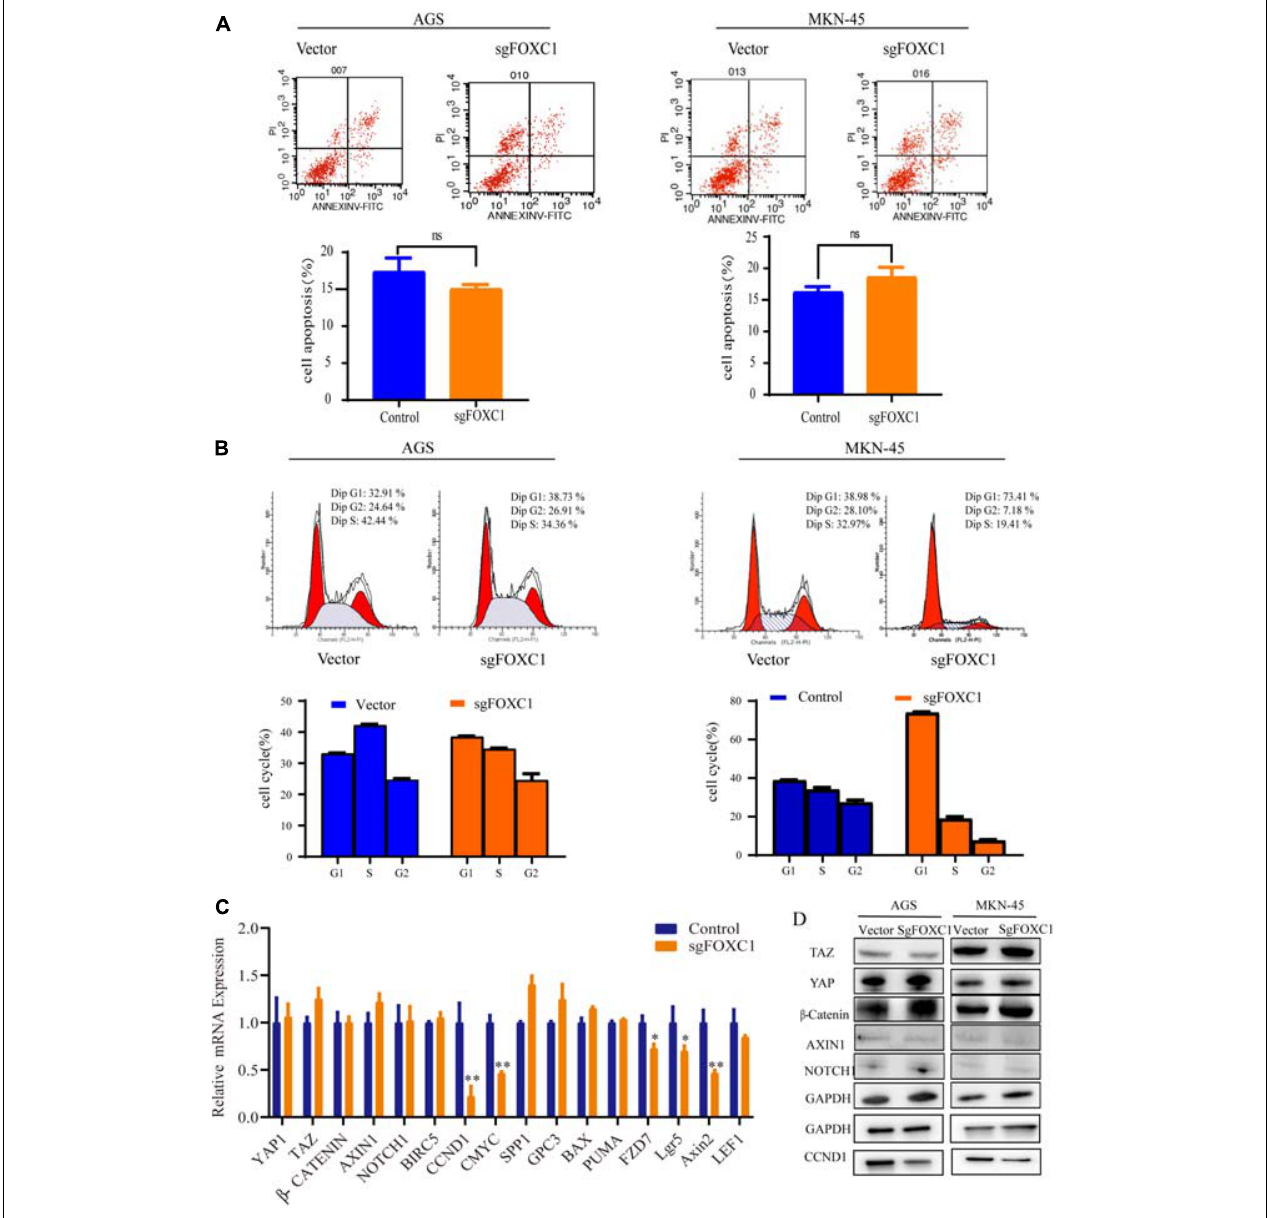
FIGURE 3 | Altered expression of FOXC1 affects the cell cycle in GC. (A) Annexin-V & Dead Cell (7-AAD) flow cytometry analysis to evaluate cell apoptosis. In the right-down panel in each plot was considered as early meaningful apoptosis. Representative figure of the three replicates of each proportion of early apoptosis was shown in panel (A) . The results flow cytometry assay on cell apoptosis in FOXC1 KO cell lines (AGS cells and MKN-45 cells) had no significant influence on cell apoptosis. Values are presented as the mean ± standard deviation of three independent experiments ( P > 0.05). (B) The results flow cytometry assay on cell cycle in FOXC1 KO cells lines (AGS cells and MKN-45 cells) showed that FOXC1 had a significant role in cell cycle regulation. Representative figure of the three replicates of each proportion of cell cycle was shown in panel (B) . Values are presented as the mean ± standard deviation of three independent experiments ( ∗ P < 0.05, ** P < 0.01). (C,D) Expression of core components of the Hippo, Wnt and Notch signaling pathways was determined by qPCR in FOXC1 KO AGS cells (C) and western blot (D) analyses in FOXC1 KO AGS and MKN-45 cells. ns, no significant difference and P >